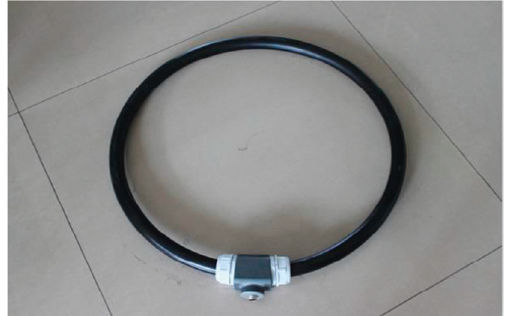
Figure 21: Receiving coil.